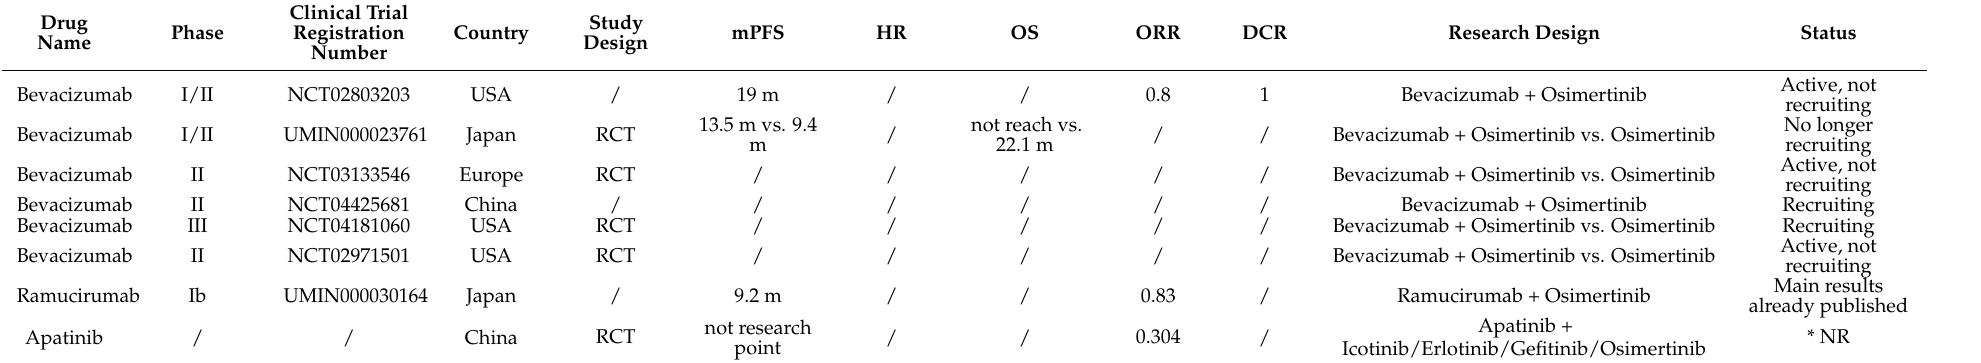
Table 4. Clinical trials of the combination of EGFR-TKIs and antiangiogenics after resistance to